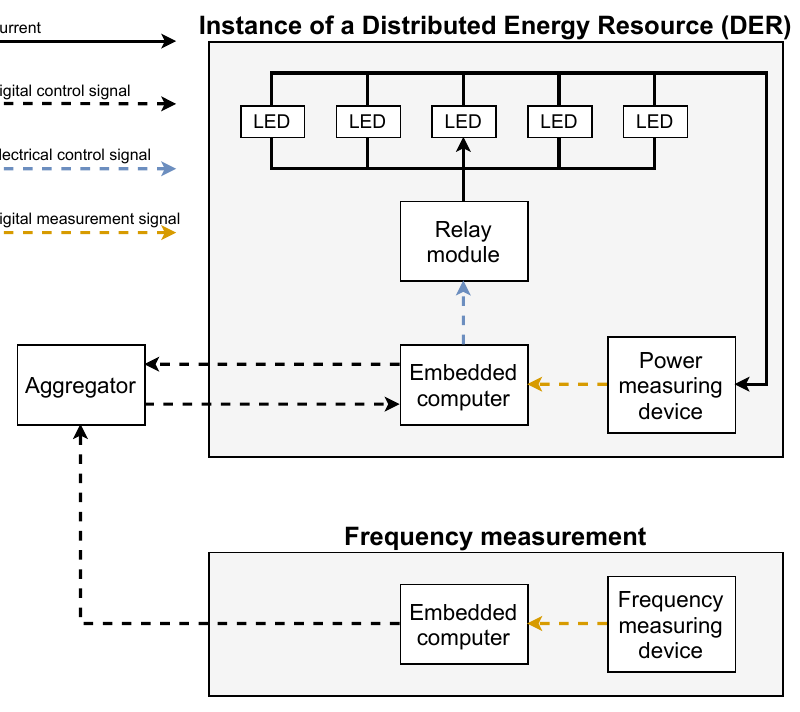
Figure 7. Block diagram of the experimental setup consisting of relay-connected distributed energy